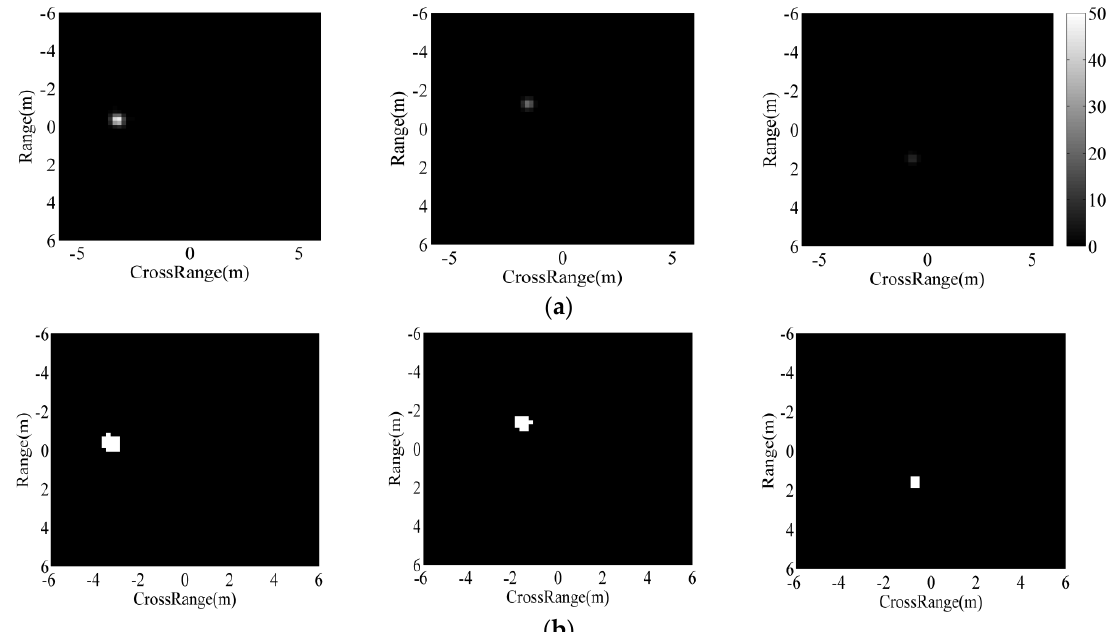
Figure 3. Images and binary regions of ASCs with different amplitudes: ( a ) images; ( b ) binary regions.